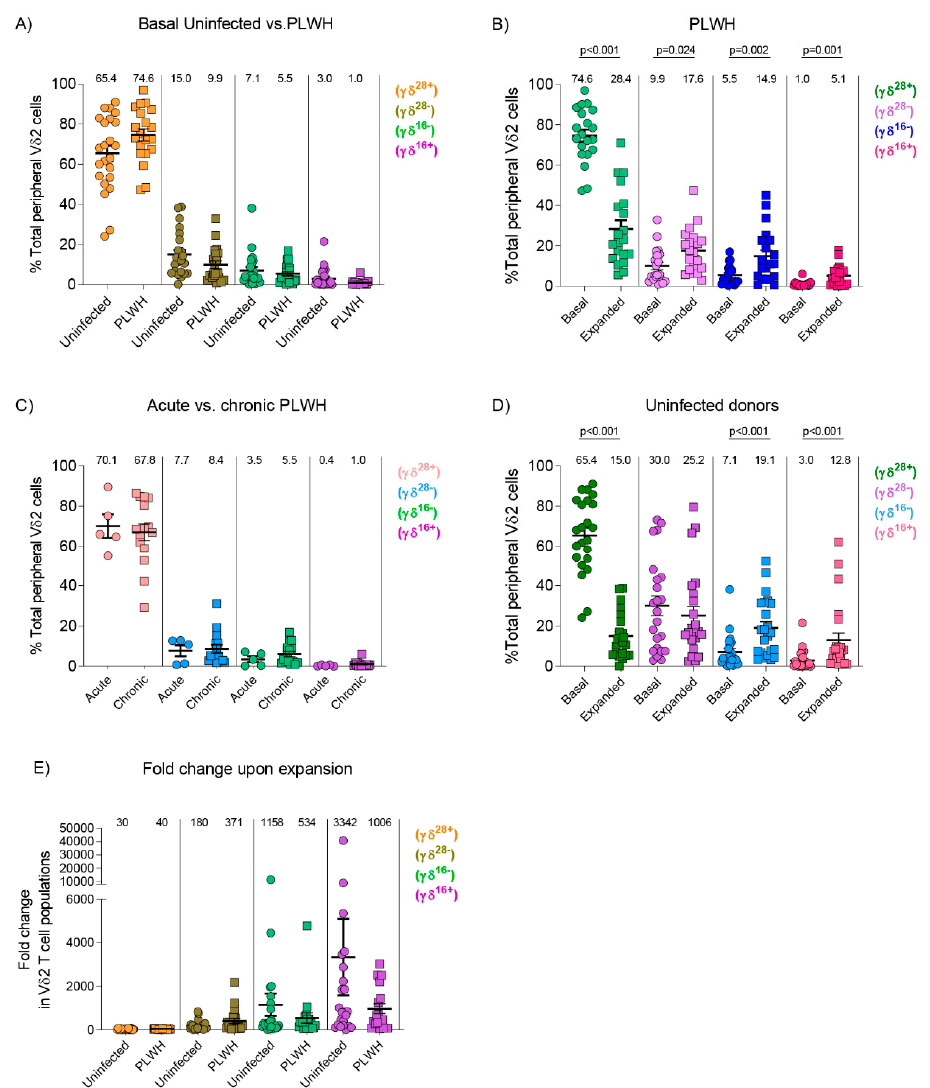
Figure 2. V δ 2 cell populations in uninfected and PLWH. γδ (28 + ) , γδ (28 − ) , γδ (16 + ) , and γδ (16 + ) V δ 2 cell populations were defined as CD27 + CD28 + CD16- ( γδ (28 + ) ); CD27 + CD28-CD16- ( γδ (28 − ) ); CD27-CD28-CD16- ( γδ (16 + ) ) and CD27-CD28-CD16 + ( γδ (16 + ) ), and analyzed in ex vivo (Basal) V δ 2 cells and after 7 days of expansion with PAM and IL-2 (Expanded) in 23 uninfected donors and 20 PLWH on ART. ( A ) Comparable ex vivo distribution of V δ 2 cell populations in uninfected donors and PLWH ( p = 0.12, p = 0.07, p = 0.54, p = 0.40, respectively, Mann Whitney U test). ( B ) Distribution of basal and expanded V δ 2 cell subpopulations in PLWH. γδ (28+) subpopulation decreased while γδ (28-) , γδ (16-) , and γδ (16+) increased after expansion (Wilcoxon paired-signed rank test). ( C ) Comparable V δ 2 cell populations between PLWH treated in the acute or chronic phase of HIV infection ( p = 0.63, p = 0.61, p = 0.67 and p = 0.77, respectively, Wilcoxon paired-signed rank test). ( D ) PAM expansion induced a decrease in the γδ (28 + ) population, an increase in γδ (16 − ) and γδ (16 + ) , while γδ (28 − ) remained unchanged ( p = 0.27) in uninfected donors (Wilcoxon matched-pairs signed rank test). ( E ) Fold-change expansion in uninfected donors and PLWH was comparable for all V δ 2 cell populations ( p = 0.15, p = 0.07, p = 0.76, and p = 0.27, respectively, Mann Whitney U test). Numbers above the symbols in panels ( A – D ) represent the mean of each V δ 2 cell population, and in panel ( E ) represents the mean fold-change (expanded / basal) in V δ 2 cell